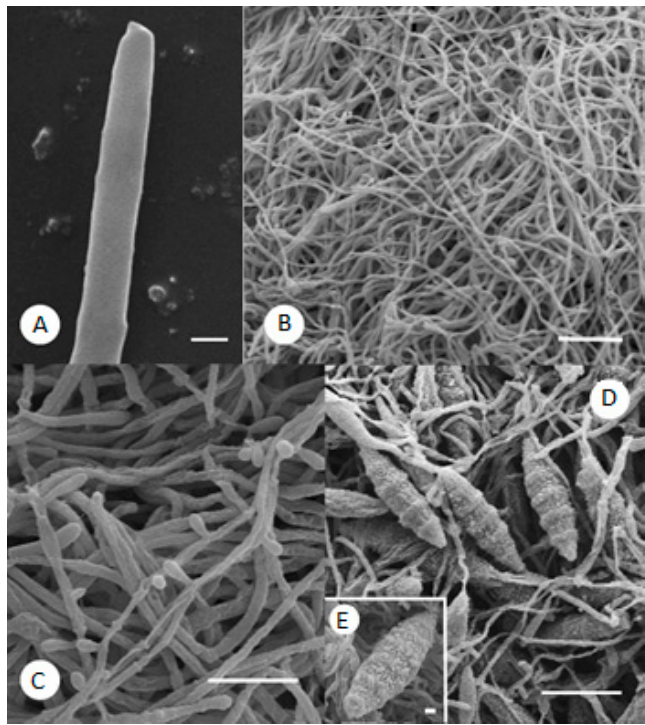
Figure 3. ( A ) Control M. gypseum : detail of straight apex with smooth wall. SEM. Scale bar: 1 μ m; ( B ) Same sample: mycelium without visible microconidia. SEM. Scale bar: 20 μ m; ( C ) M. gypseum treated with 20 μ g/mL phenylethylresorcinol: microconidia are visible. SEM. Scale bar: 10 μ m; ( D ) M. gypseum treated with 100 μ g/mL phenylethylresorcinol: numerous macroconidia in the mycelium. SEM. Scale bar: 20 μ m; ( E ) Same sample: typical cigar-shaped macroconidium with knobs on the surface. SEM. Scale bar: 2 μ m.